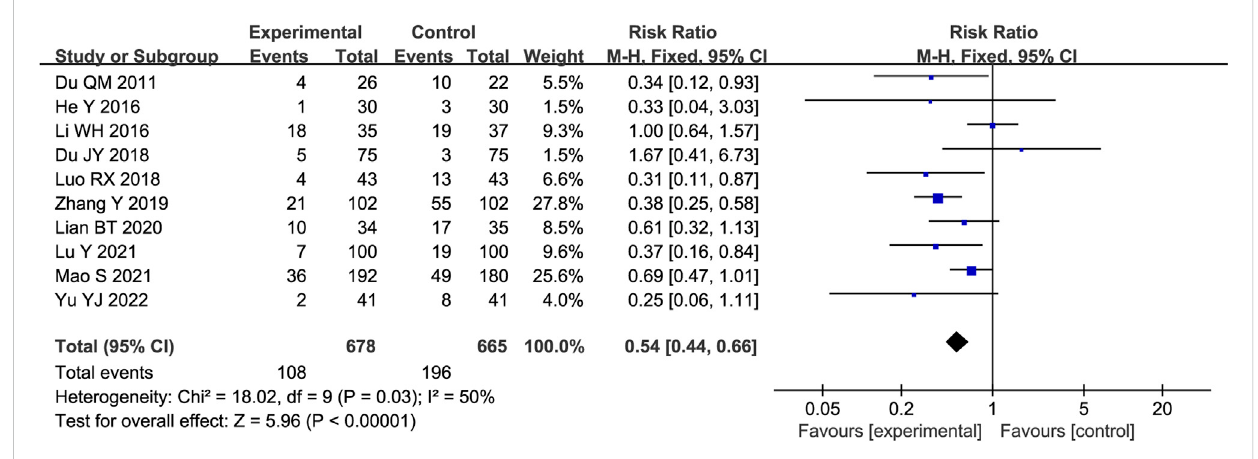
FIGURE 7 Forest plot of major adverse cardiovascular events (MACEs).